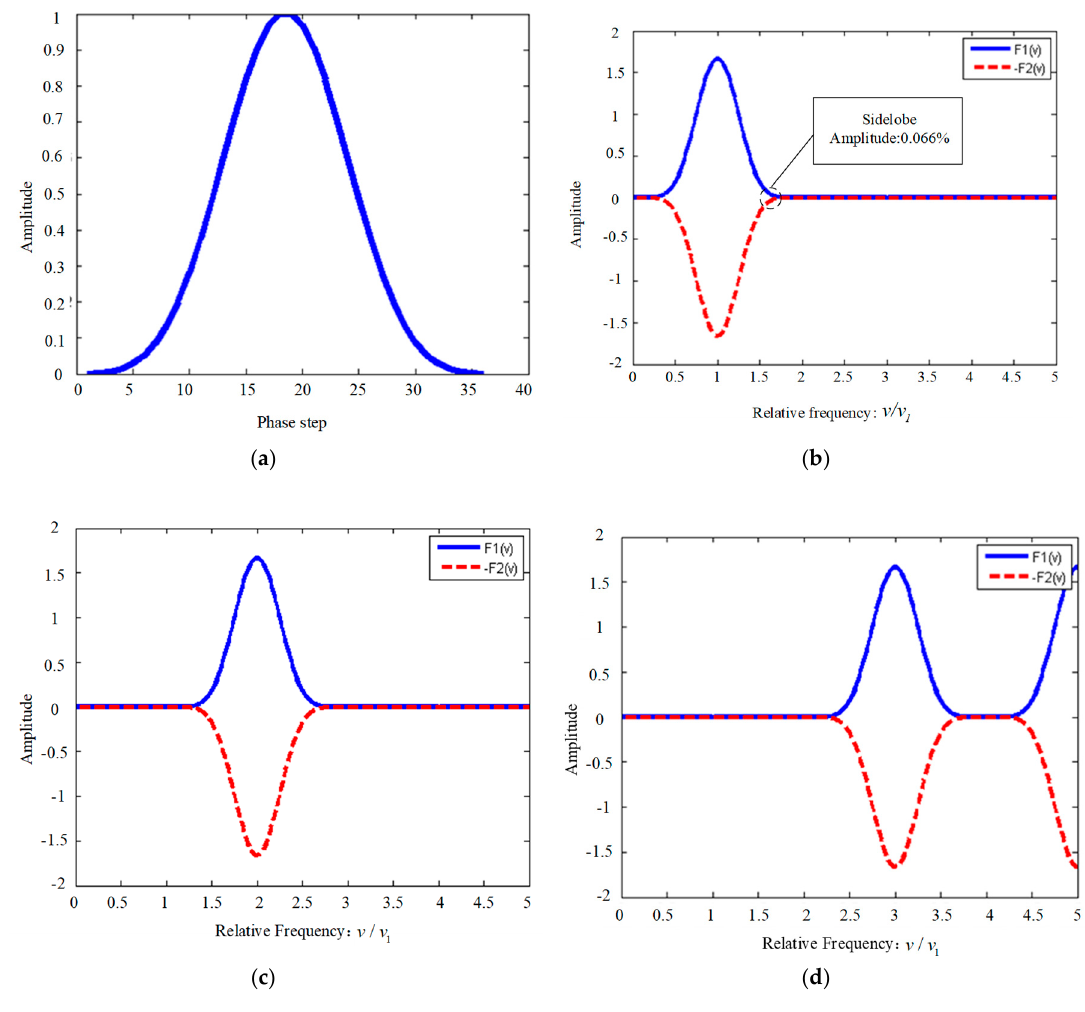
Figure 3. New window function of the 36-step algorithm. ( a ) Shape of the new window function of the 36-step algorithm defined by w ( 36 ) ; ( b ) new window function of the 36-step algorithm in the thickness measurement; ( c ) new window function of the 36-step algorithm in front-surface measurement; ( d ) new window function of the 36-step algorithm in the rear-surface measurement.